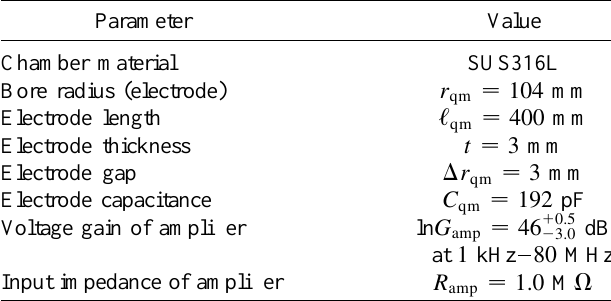
TABLE II. Design parameters of quadrupole monitor. Parameter